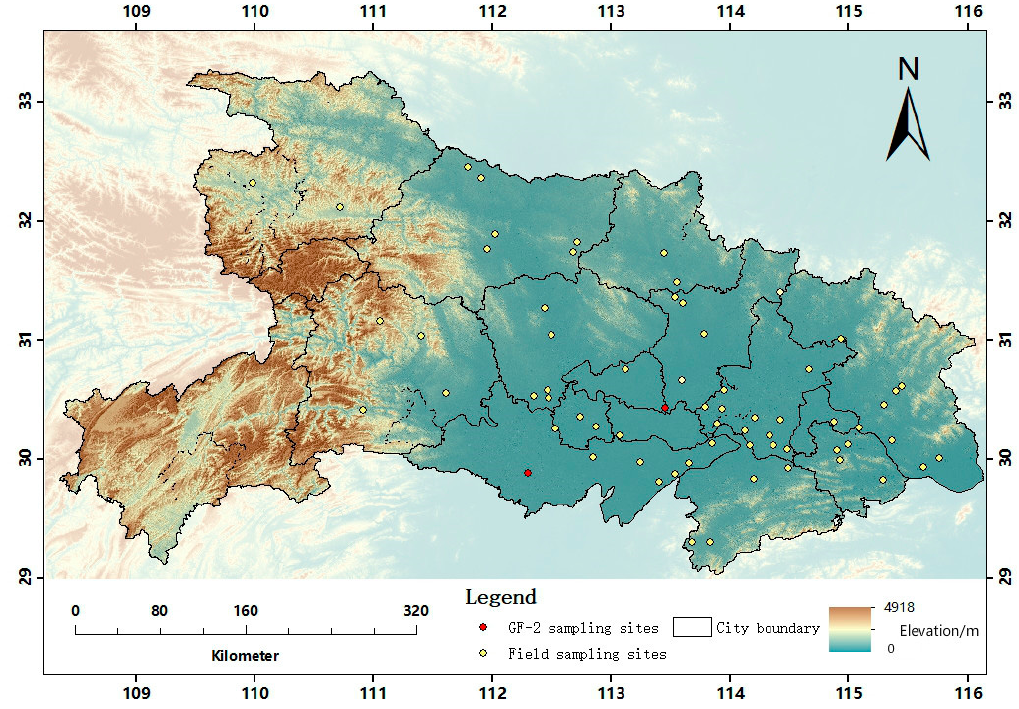
Figure 1. Study area and location of sampling sites.